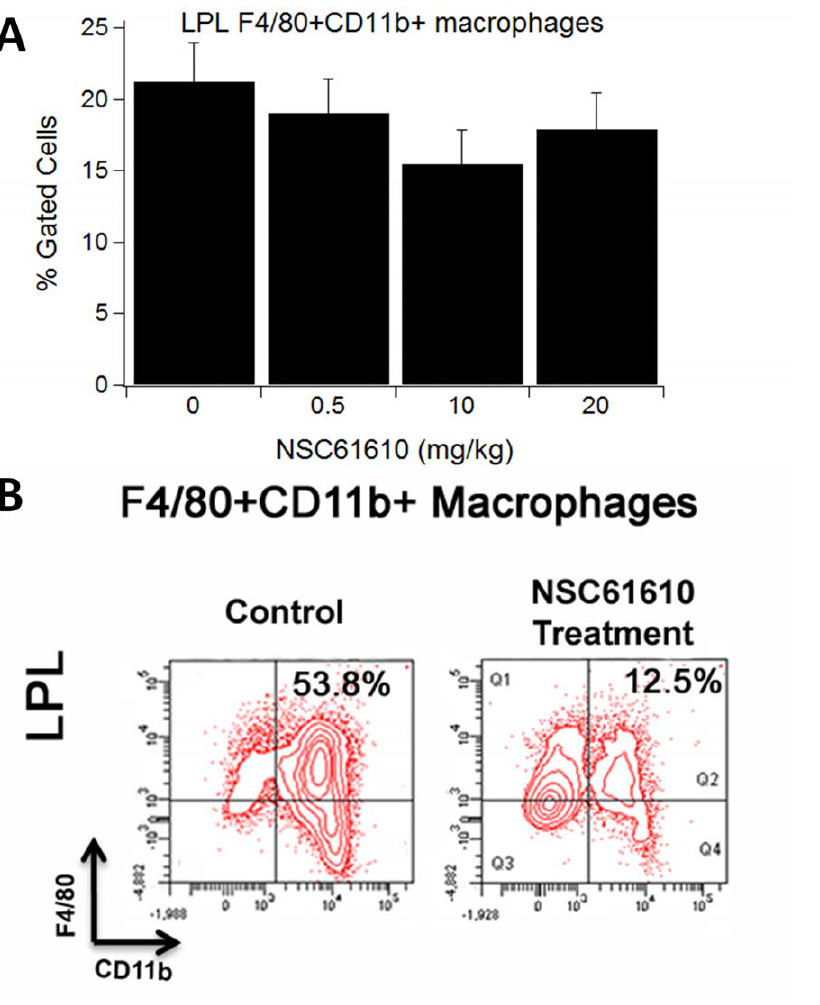
Figure 7. Oral treatment with NSC61610 on the distribution of macrophages in colonic lamina propria. Colonic lamina propria lymphocytes (LPL) were immunophenotyped to identify F4/80 + CD11b + macrophage subsets through flow cytometry. Data are represented as mean 6 standard error (n=10). Bars with an asterisk indicate that a treatment is significantly different from its control ( P , 0.05 ).